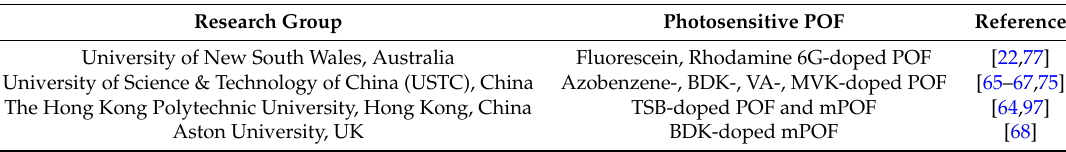
Table 2. Photosensitive POFs developed by several research